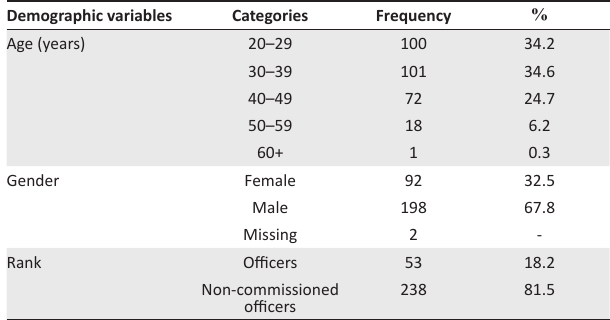
TABLE 1: Sample frequencies: Age, gender and rank ( n =